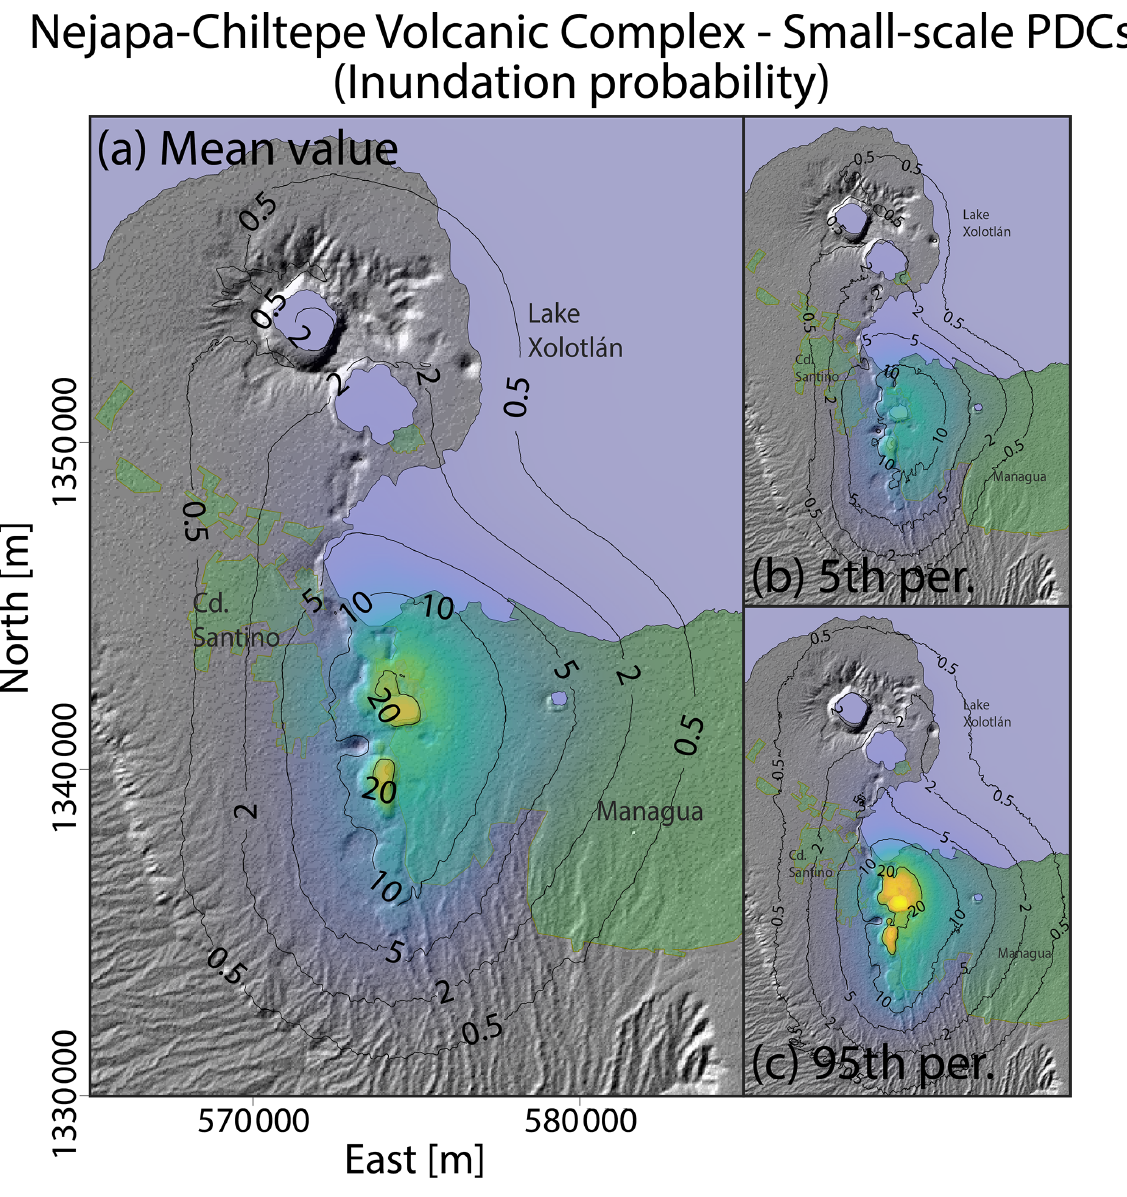
Figure 9. Inundation probability of small-scale PDC at the Nejapa-Chiltepe volcanic complex derived from the systematic application of the branching energy cone model (Aravena et al., 2020a) and the vent opening probability map shown in Fig. 7. (a) Mean value. (b) 5th percentile. (c) 95th percentile. Inundation probability is expressed in percentage. These probability maps are conditioned on the occurrence of an eruption able to produce small-scale